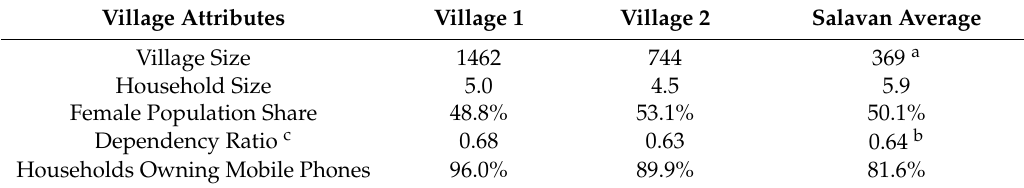
Figure 1. Site map and research timeline in Lao PDR. Source: Authors, adapted from Google Inc. [18]. Table 1. Characteristics of survey villages compared to the provincial average.